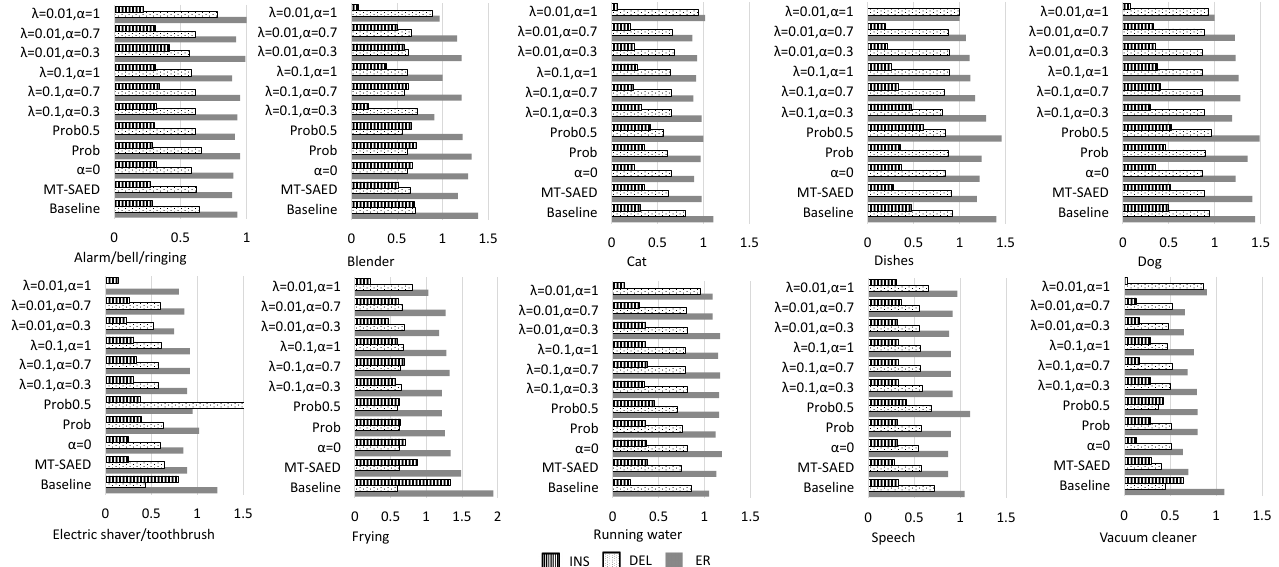
Figure 4. Results of different models for each event on the DCASE2019